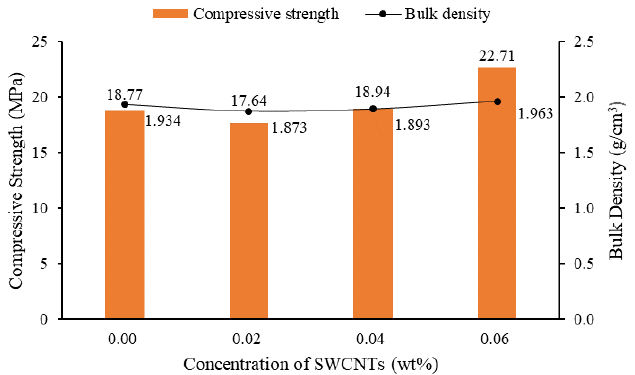
Figure 12. Variation of 28-day compressive strength and bulk density of TX10-treated specimens as a function concentration of SWCNTs.